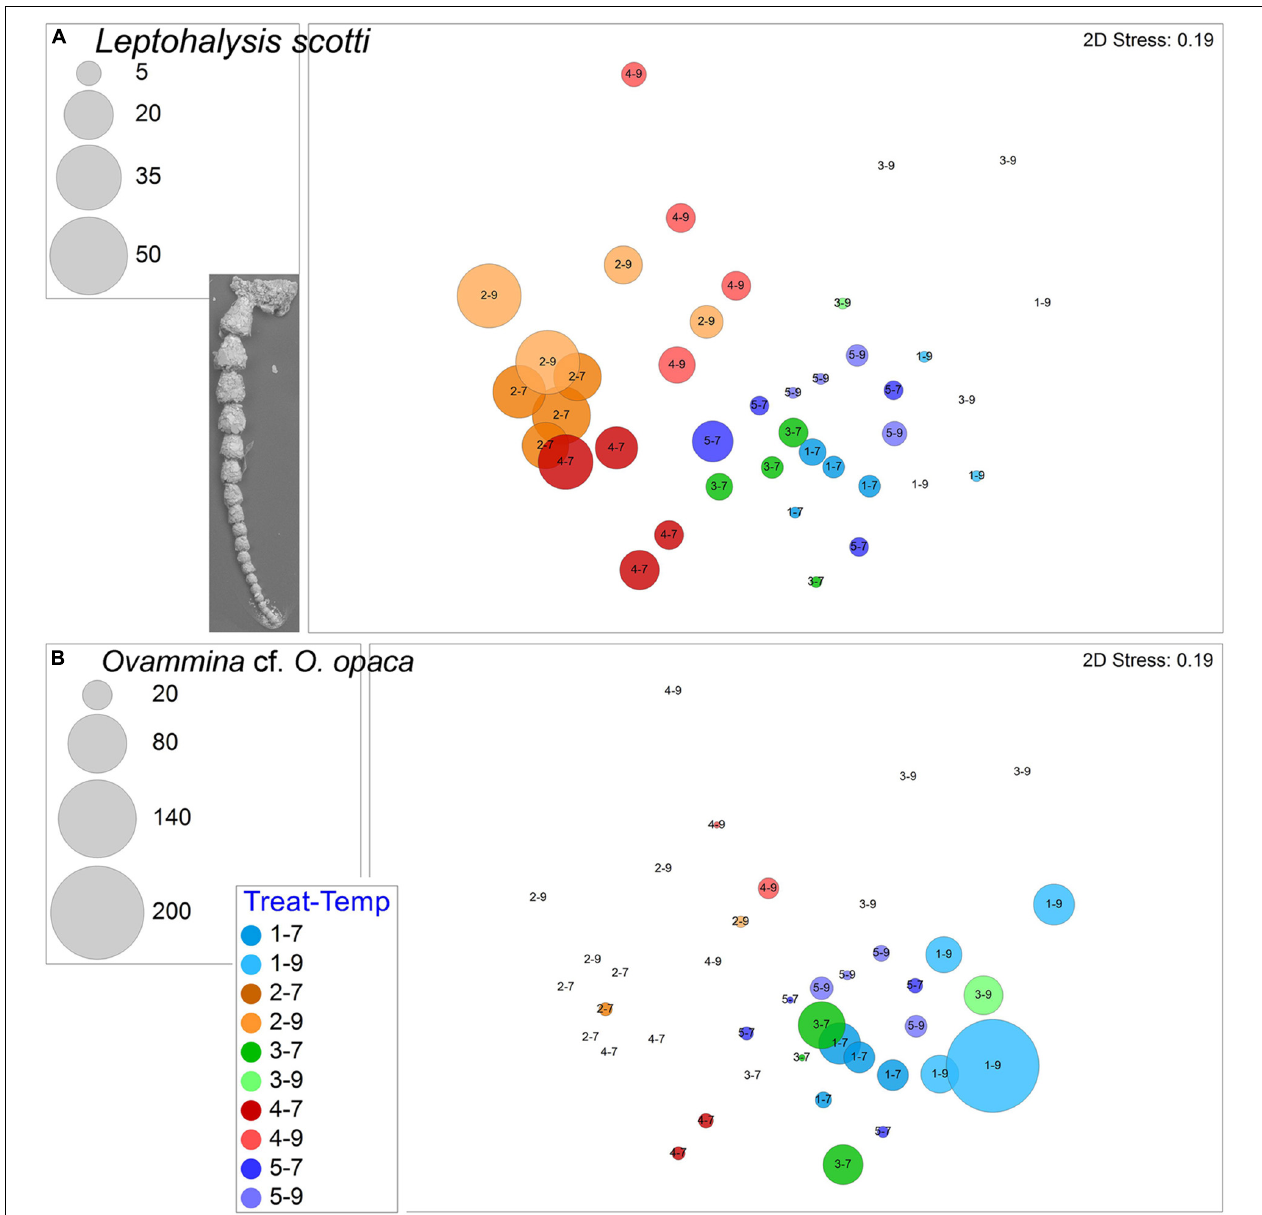
FIGURE 7 | (A) Bubble plots projecting abundances in containers (7 ◦ C Total/9 ◦ C Live) by morphospecies on 2-D nMDS plots. Bubbles are color coded to treatment; lighter shade represents warmer assemblages. Circle diameter is keyed to abundance. (A) Leptohalysis scotti , inset is SEM image; (B) Ovammina cf. O. opaca . Treatment 1 (blue) is Present Day; Treatment 2 (orange) is Hypoxia; Treatment 3 (green) is OA; Treatment 4 (red) is OA + Hypoxia; Treatment 5 (purple) is